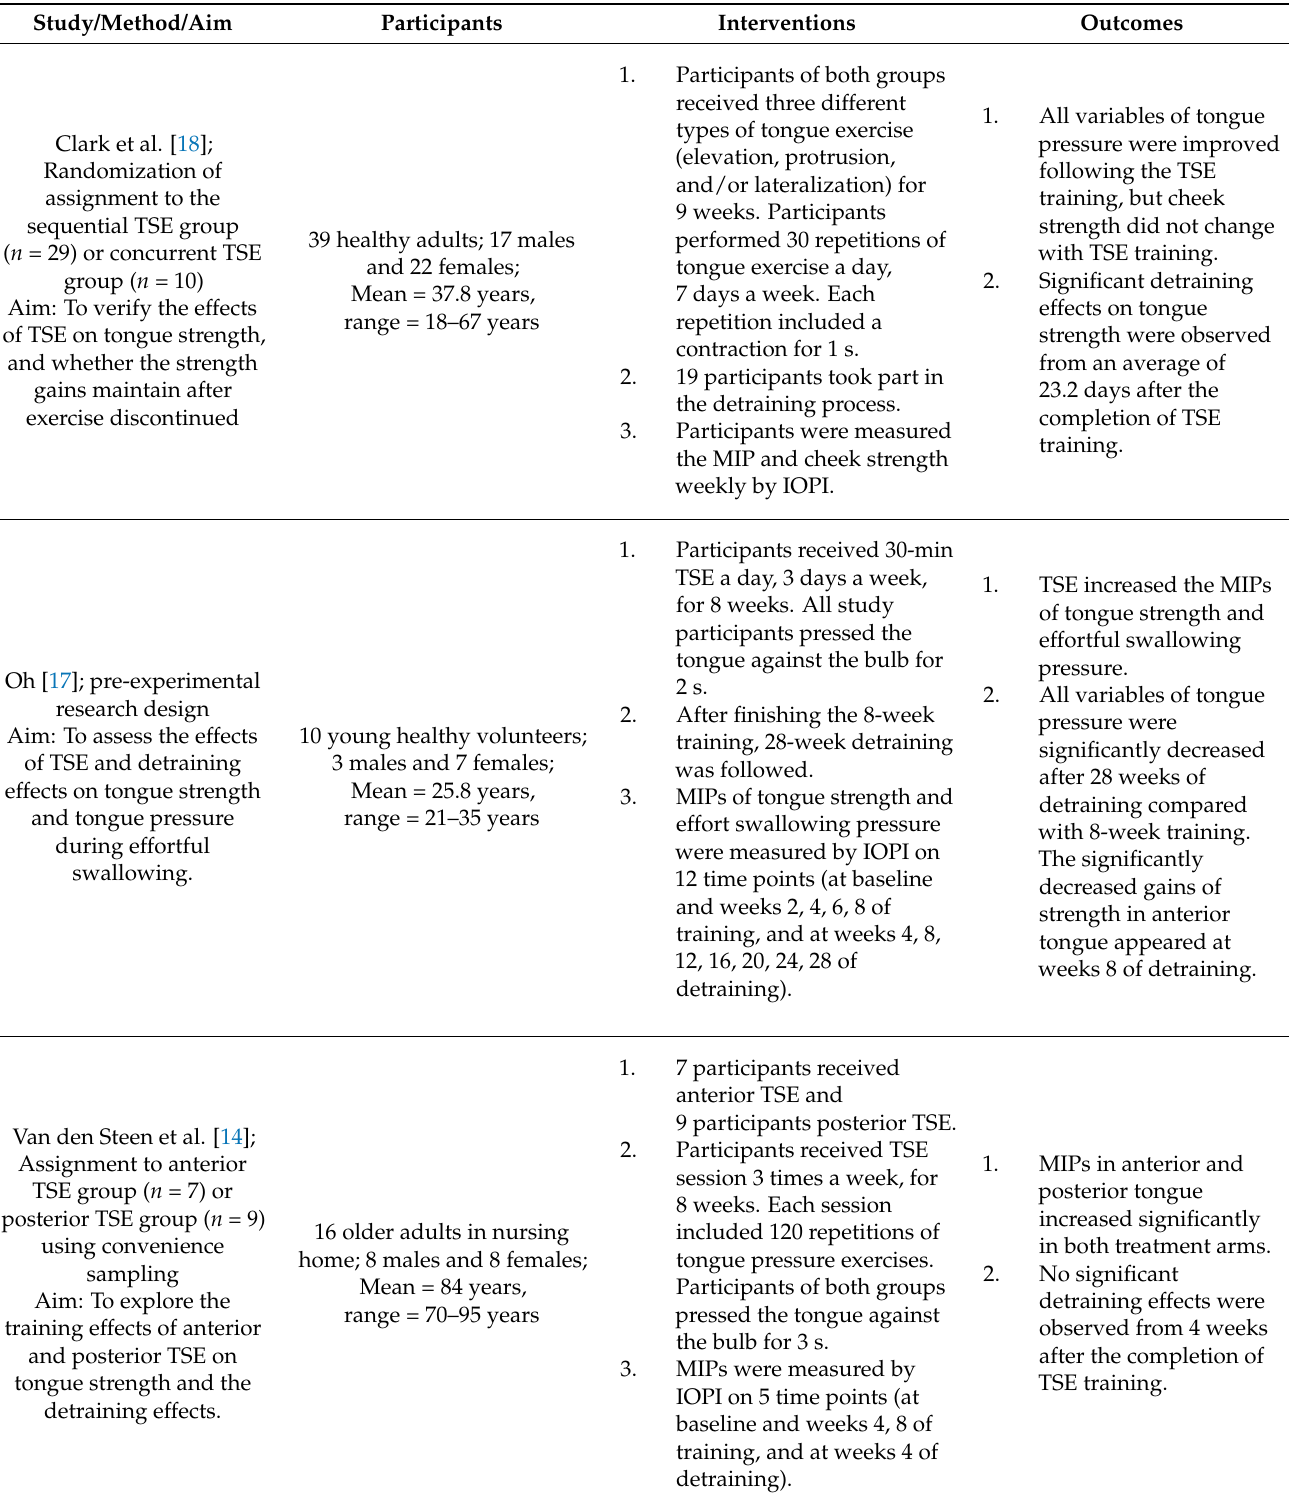
Table 5. Comparisons of the TSE training effects and detraining